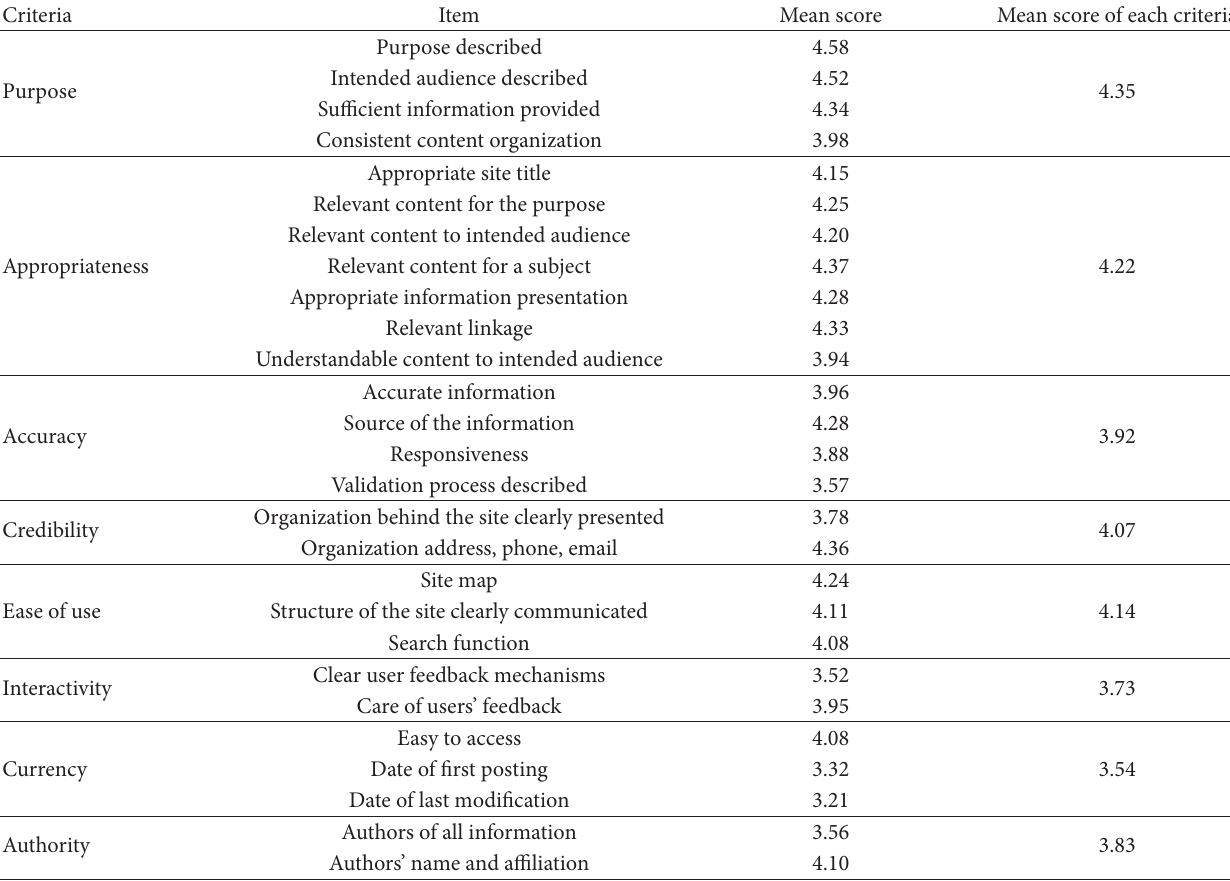
T 3: Online program evaluation by expert panel (